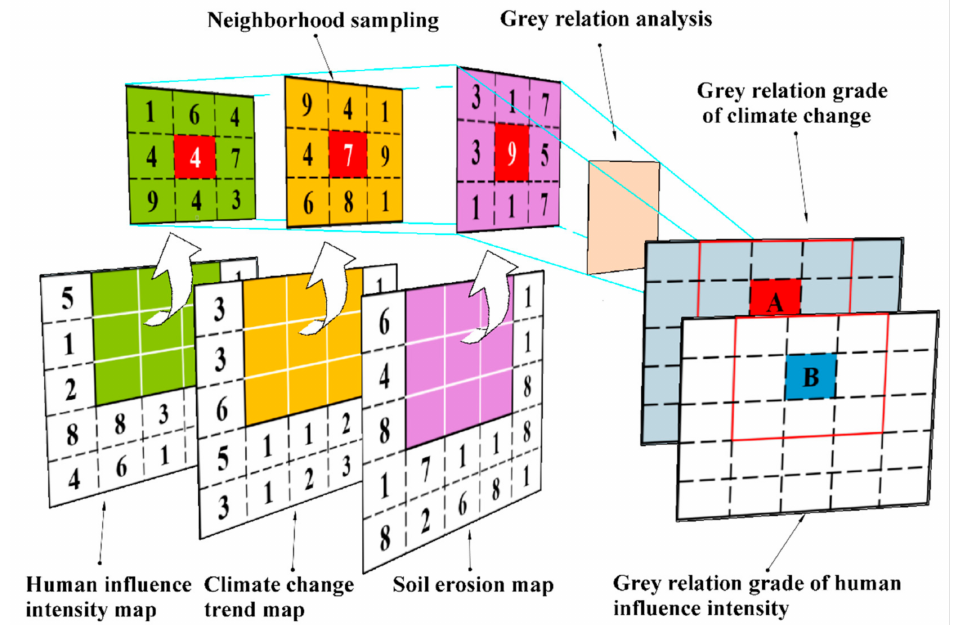
Figure 2. Schematic diagram of the neighborhood sampling for the grey relation analysis (GRA).